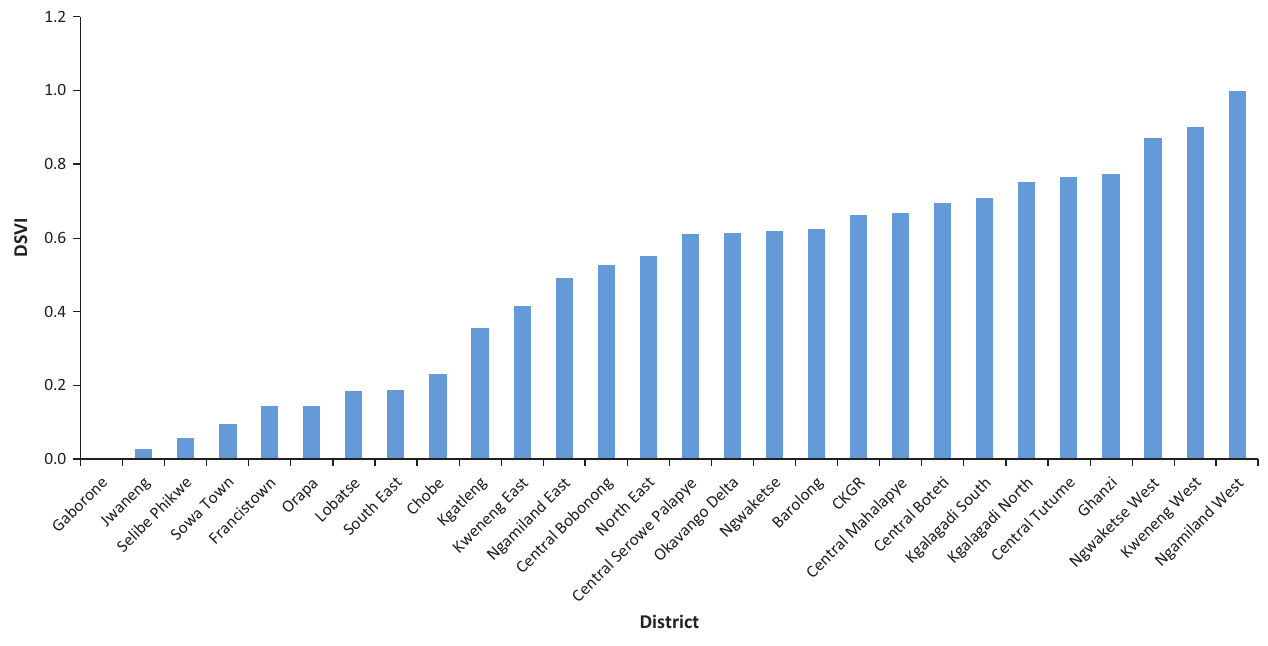
FIGURE 3: Ranked District Social Vulnerability Index scores from the lowest to the highest by district. DSVI, District Social Vulnerability